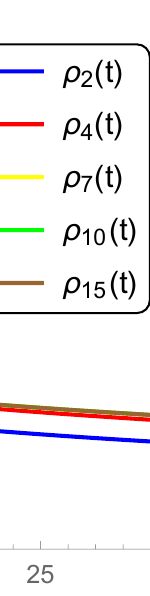
Figure 3. Graphs of the n -th approximate solution of (11), (12) with n = 2,4,7,10,15 and λ = 1, α = 0.5, and q =